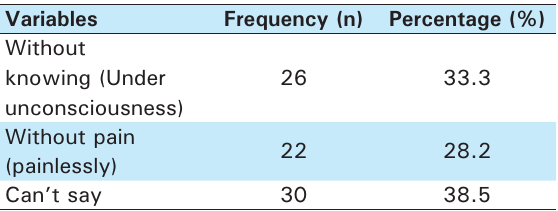
Table 2. Patients’ preferences for undergoing